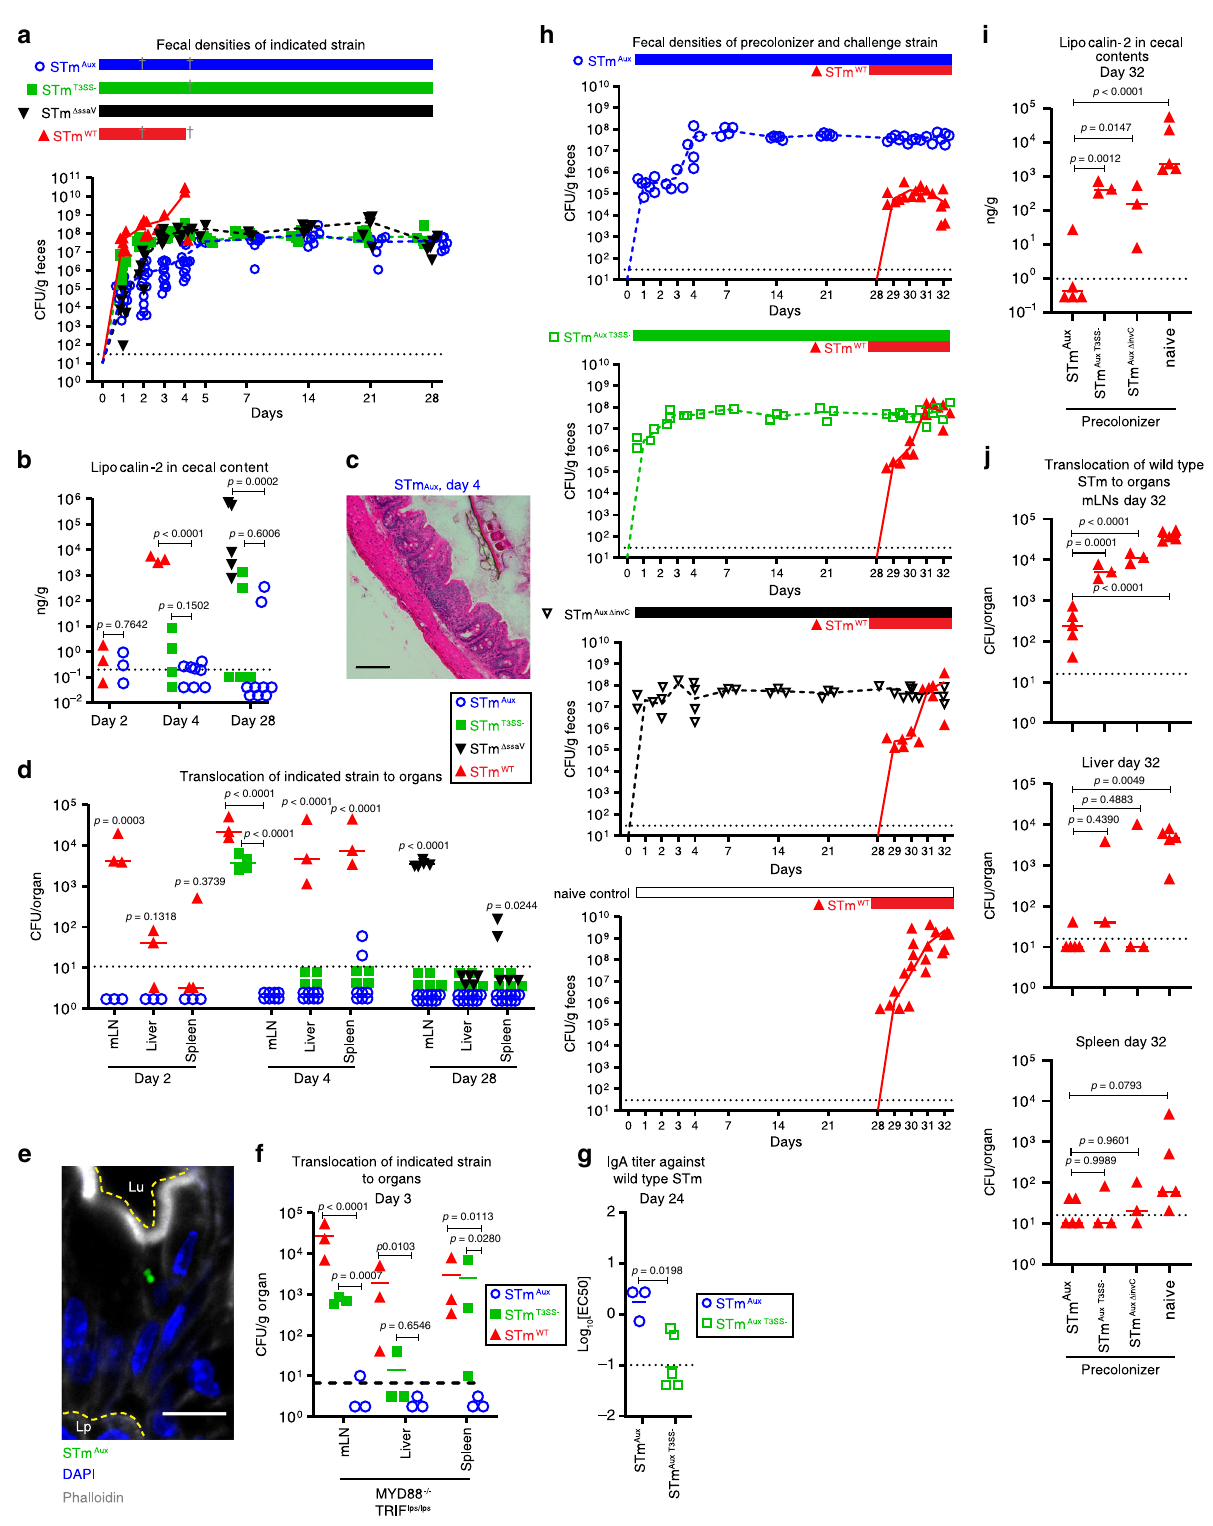
Methods Bacterial strains, plasmids, and culture media . The bacterial strains and plas- mids used in this study are listed in Table 1. Auxotrophic strain HA135 (STm Aux